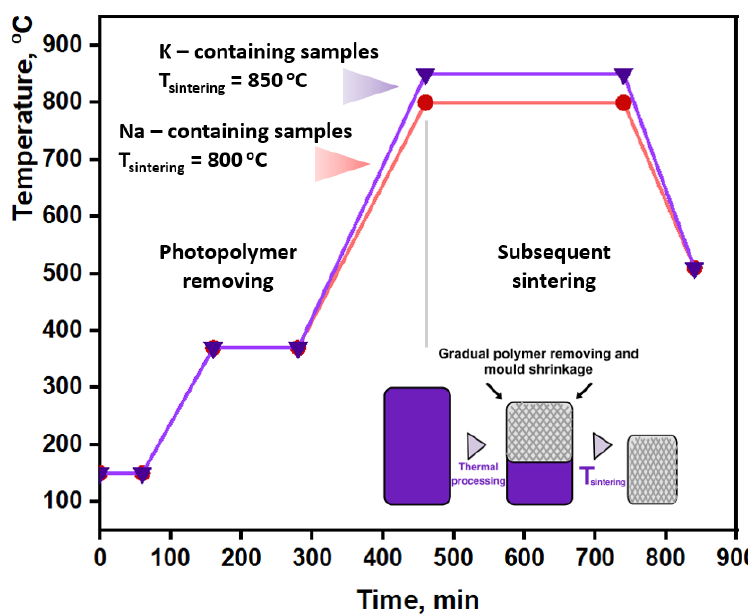
Figure 1. Time − temperature schedule to burn out photocured resin and to sinter ceramic residue.